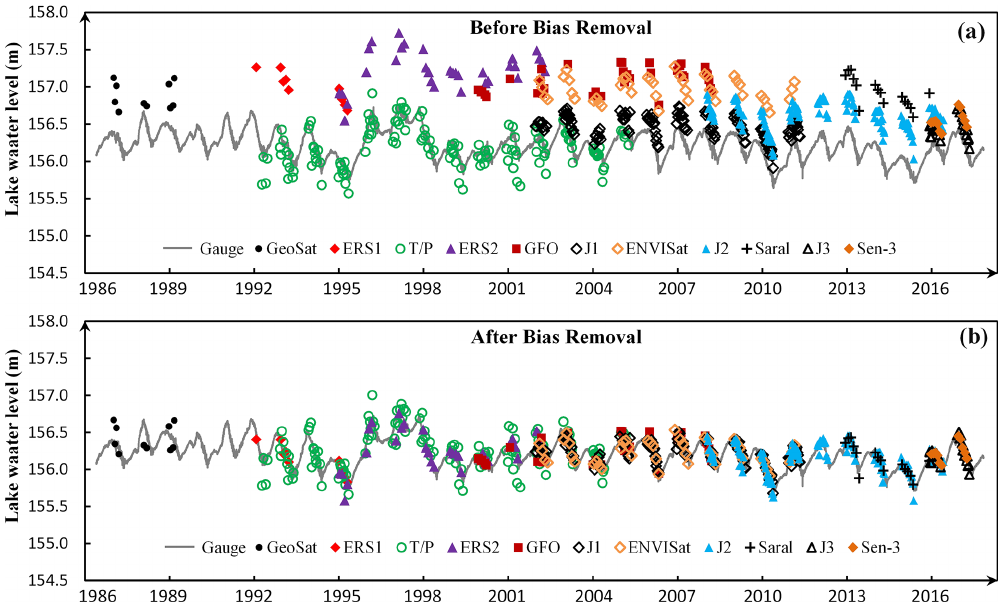
Figure 4. The long-term time series of lake water level derived from the 11 satellite radar altimetry missions for Great Slave Lake in Canada. (a) The biases between altimetry-derived estimates and gauge measurements were not removed. (b) The biases were